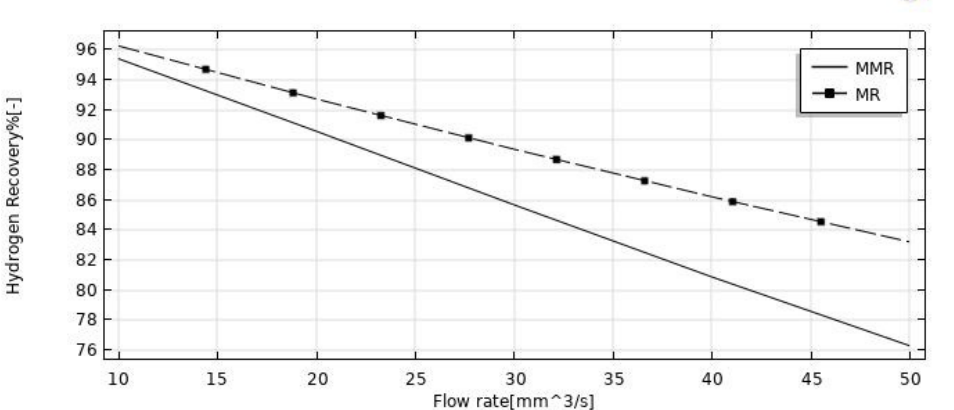
Figure 8. Hydrogen recovery vs. feed flow rate for both the MMR and the MR at p = 1 bar, T = 400 °C, and sweep gas flow rate = 333.33 mm 3 /s.